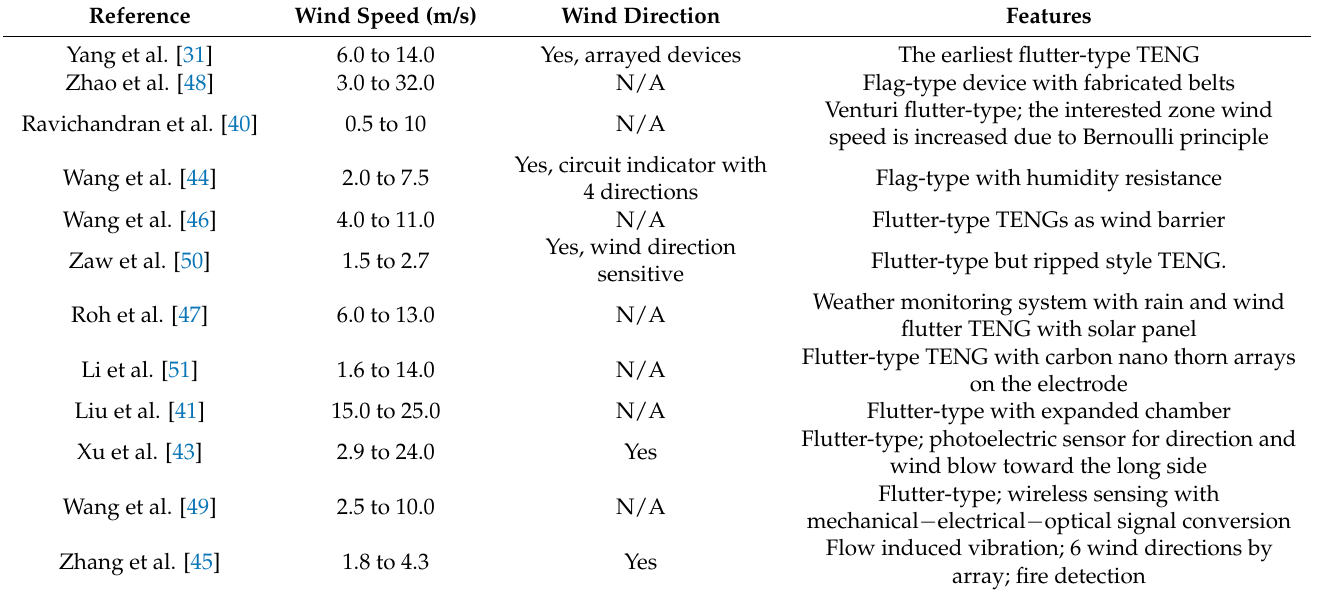
Table 2. Summary of flutter- and flag-type TENG